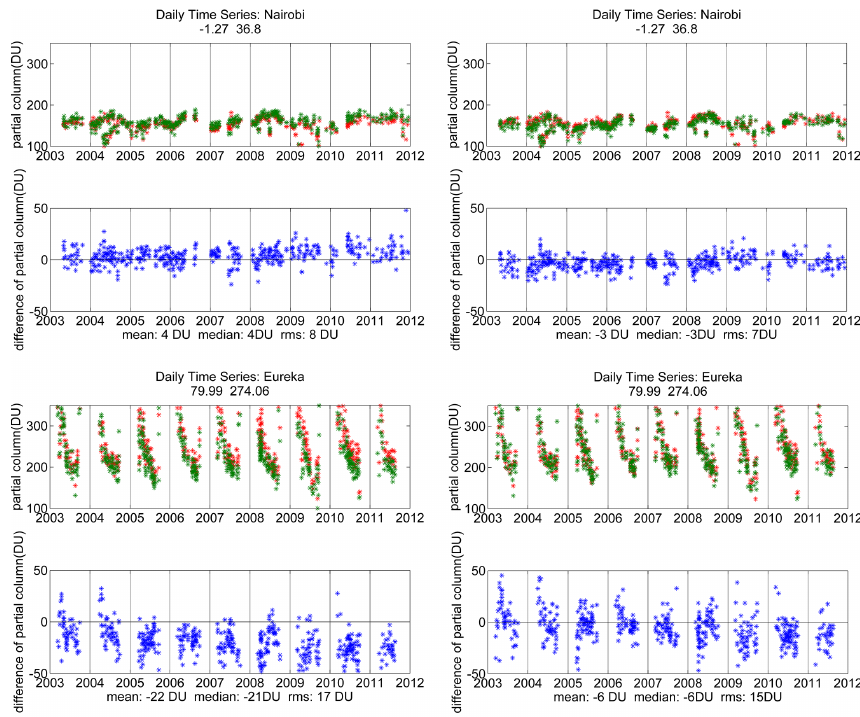
Figure 6. Time series of stratospheric ozone partial columns from SCIAMACHY V2.9 and V3.0 (left and right panels, respectively) limb data (green), ozonesonde data (red) (upper panel) and their absolute difference in SCs (blue) in DU. The results are presented unsmoothed.